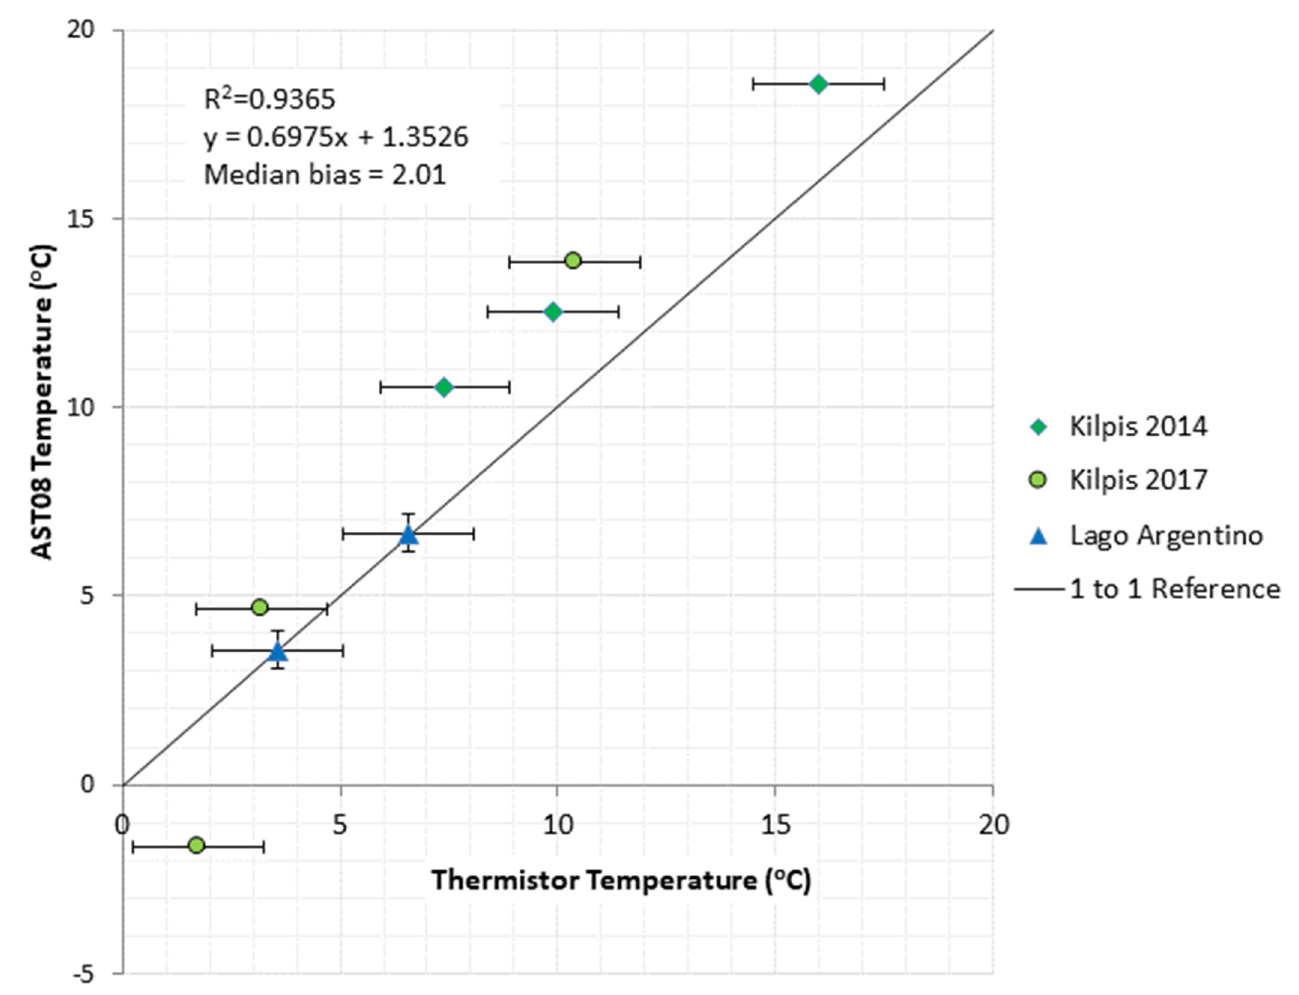
Figure 4. Validation of AST08 surface temperatures ( ± 1.5 ◦ C shown as error bars) plotted against contemporaneous near-surface (<2 m depth) in situ lake water temperatures. The full dataset linear regression value is R 2 = 0.9365 and median bias = 2.01 (AST08 thermistor values). Green data points from an RBR Duo thermistor (accuracy ± 0.002 ◦ C) temperatures (every minute) from in situ buoys in Kilpisjarvi, Sweden (from G. Kirrilin). Blue data points are from Onset HOBO U20 sensor (accuracy ± 0.5 ◦ C) mounted on a metal pole at a <2 m depth in Brazo Rico (near Perito Moreno Glacier), arm of Lago Argentino, Argentina (from M. Minowa).